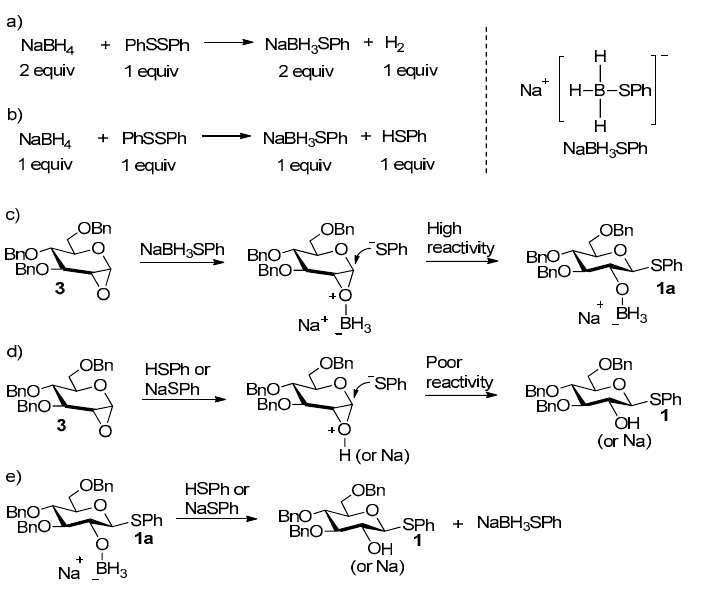
Figure 3. Proposed reaction mechanism. Table 1. Comparison of results by variation of reaction conditions a .